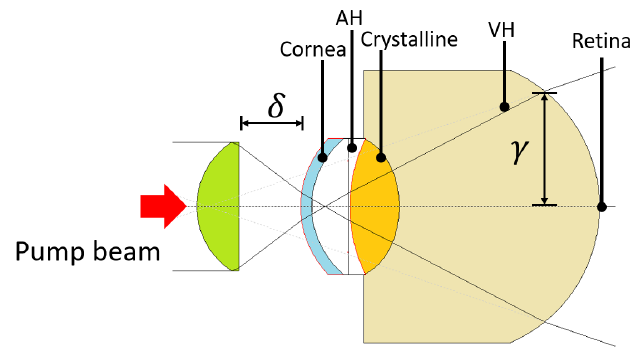
Figure 6. Simulation on WinLens3D Basic of the pump beam propagation through the pig eye